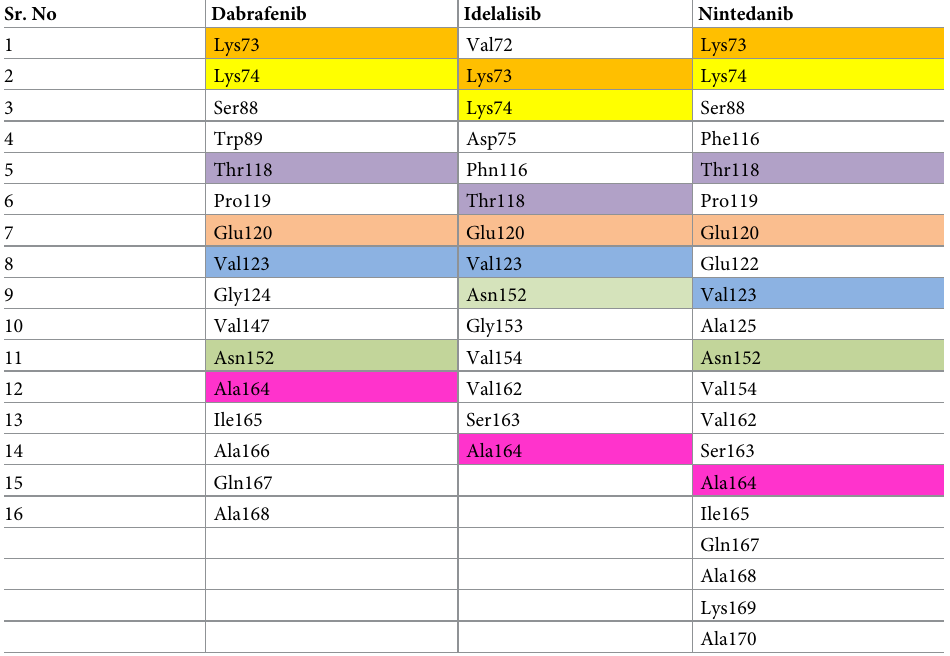
Note- Similar residues are indicated with same